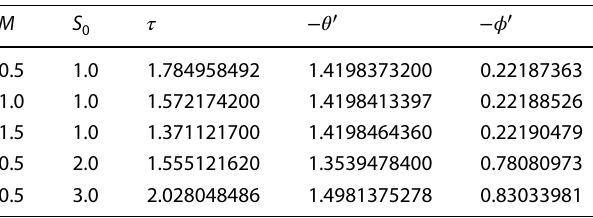
Table 2 Computed values for the local skin friction, rate of heat transfer, and rate of mass transfer for different values of M and S 0 tak-